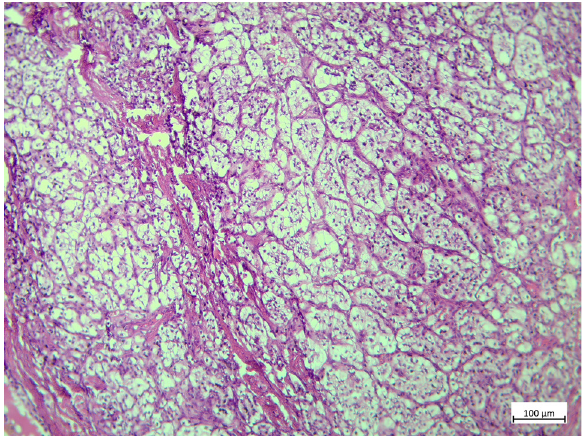
Figure 1: Histopathological examination and immunohis- tochemistry staining revealed bilateral testicular metastases from renal clear cell